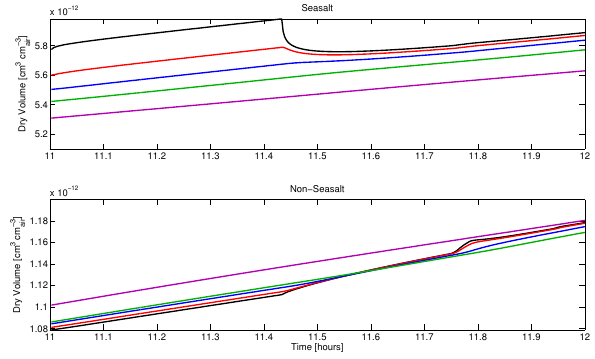
Fig. 4. Total dry volume for the seasalt and non-seasalt modes at different levels through the model column for the base case, low tide, model run. Black, red, blue, green, and purple lines represent mixing ratios at heights of 0.5, 8, 60, 250 and